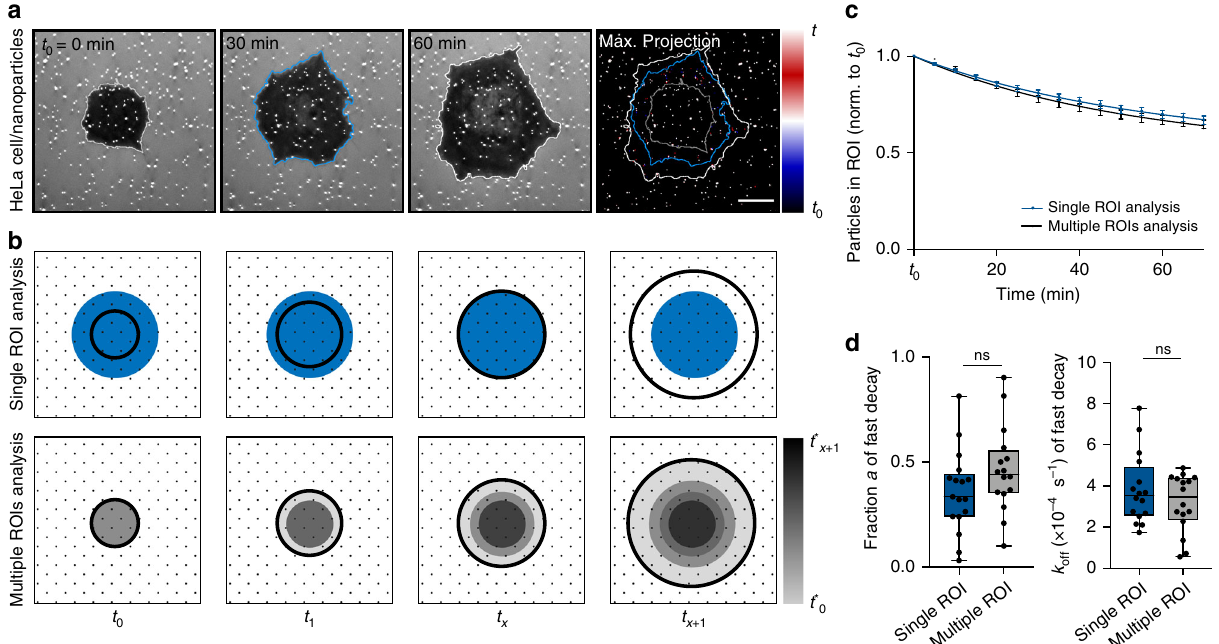
Fig. 3 Kinetic analysis of removal of surface-bound particles shows spatial preference for cell periphery. a Interference re fl ection microscopy images of a HeLa cell spreading and tearing off biotin-neutravidin surface immobilized virus-sized gold nanoparticles. Where the cell formed close contacts with the substrate, light re fl ection and interference with the incident light creates the dark contrast. The nanoparticles scattered the incident light and thus appear bright. In the maximum projection with temporal color-code stable particles are displayed in white, while particles that were removed within the fi rst 30 min are blue and particles that were moved between 30 and 60 min appear red and the cell outline at t 0 + 30 min is printed in blue. Scale bar, 10 µ m. b Schematic of the regions of interest (ROIs) for single ROI analysis and analysis using multiple ROIs. In the single ROI analysis, we considered particles, which fall within the blue ROI de fi ned as the projected cell area (black circles) at t x = t 0 + 30 min Data were normalized to the particles in this ROI at t 0 . In the analysis using multiple ROIs we grouped particles (similar gray areas), that stayed underneath the projected cell area for at least the indicated interaction time t *. Data were normalized to the available number of particles per interaction time and corrected for the already torn off particles at all shorter times. c Normalized number of surface-bound nanoparticles without ligands under HeLa cells over time either analyzed in a single ROI or multiple ROIs. Data are represented as mean ± s.e.m. and fi tted with two-phase decay functions . d For the particles being actively removed by the HeLa cells, the fraction a and the off rate k off are shown as obtained by fi tting from the two-phase-decay of particles ( n = 16 cells, 3 technical replicates, box-plots represent median ± 95% CI with whiskers to the min and max values, one-way ANOVA with post hoc Tukey test). Source data are provided as a source data fi